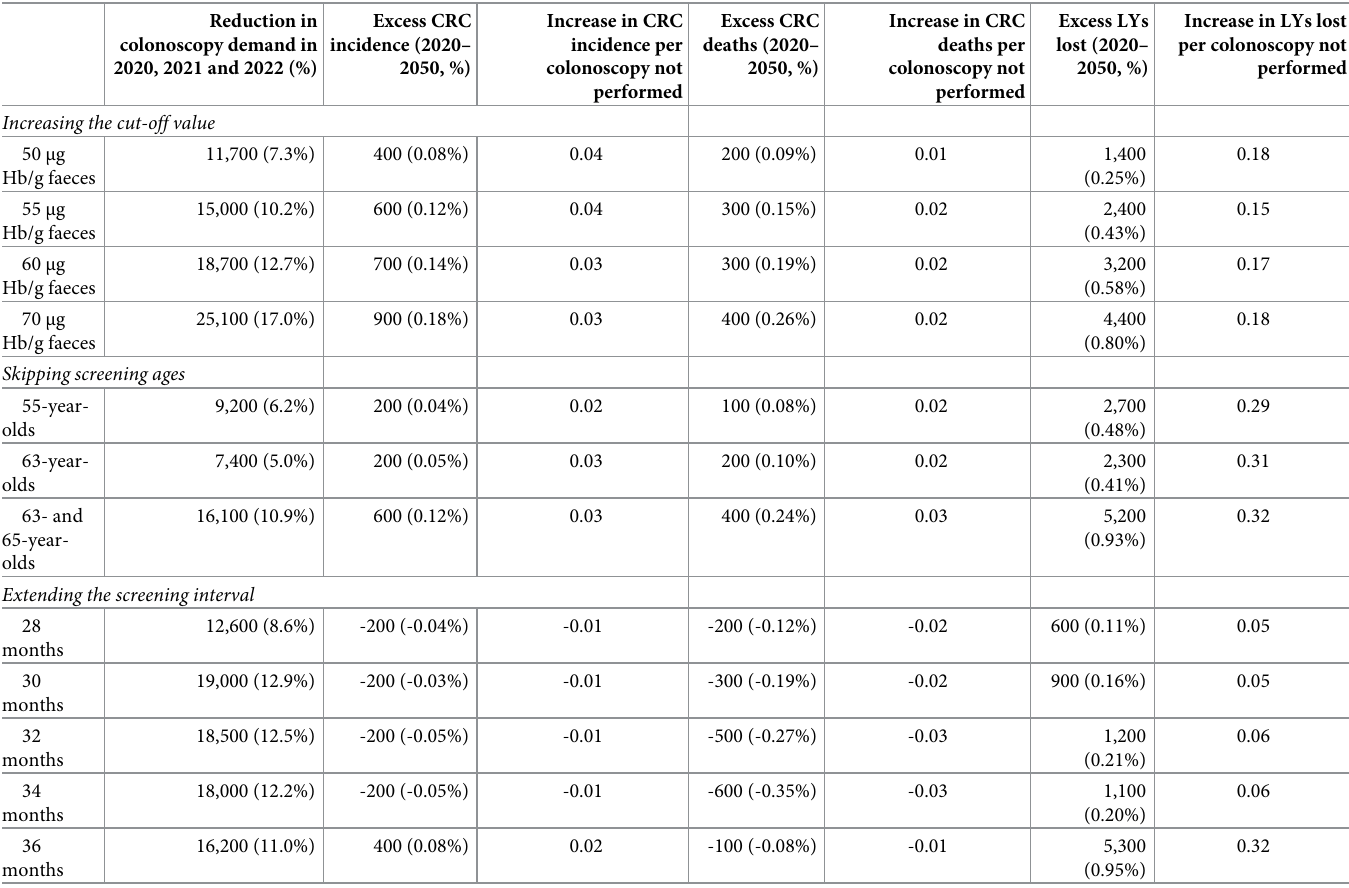
Table 1. The efficiency of strategies to reduce colonoscopy demand predicted by